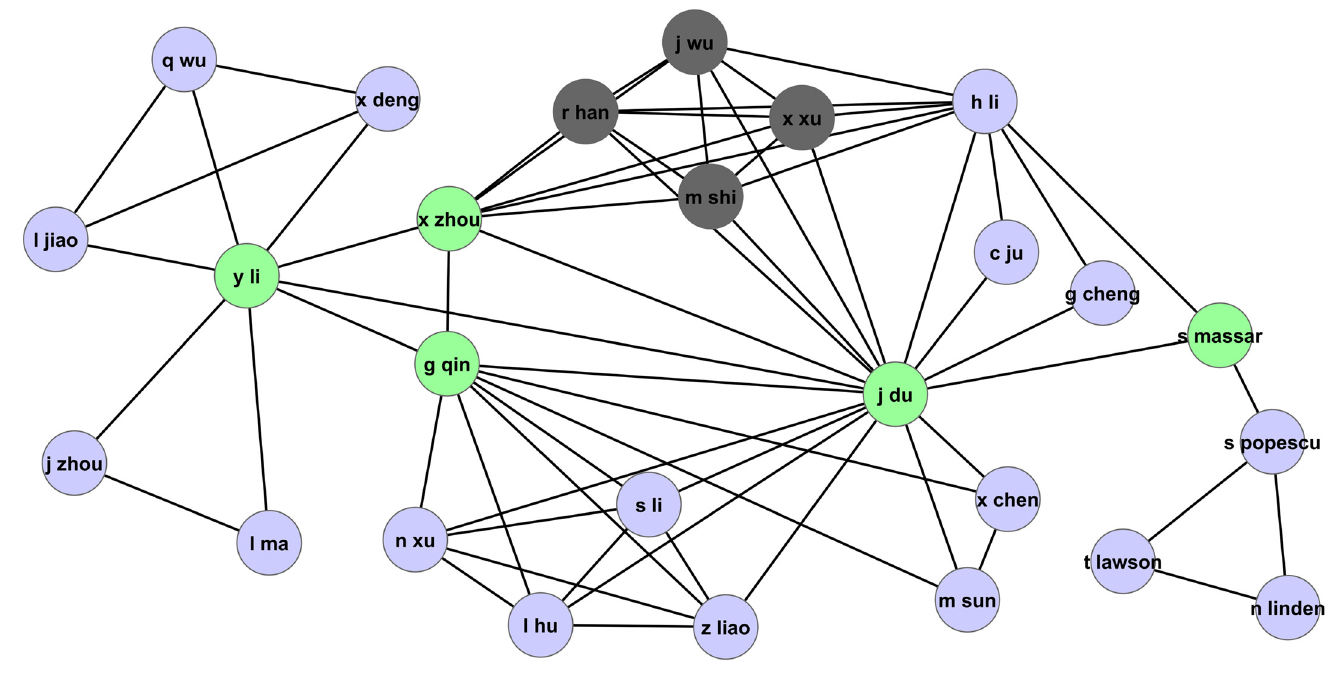
Fig 15. Part of the collaboration network highlighting authors R. Han (h-index: 8, pagerank-index: 79.6%), X. Xu (h-index: 8, pagerank-index: 95.1%), J. Wu (h-index: 1, pagerank-index: 89.3%), and M. Shi (h-index: 3, pagerank-index: 79.1%) in the field of Quantum Game Theory.